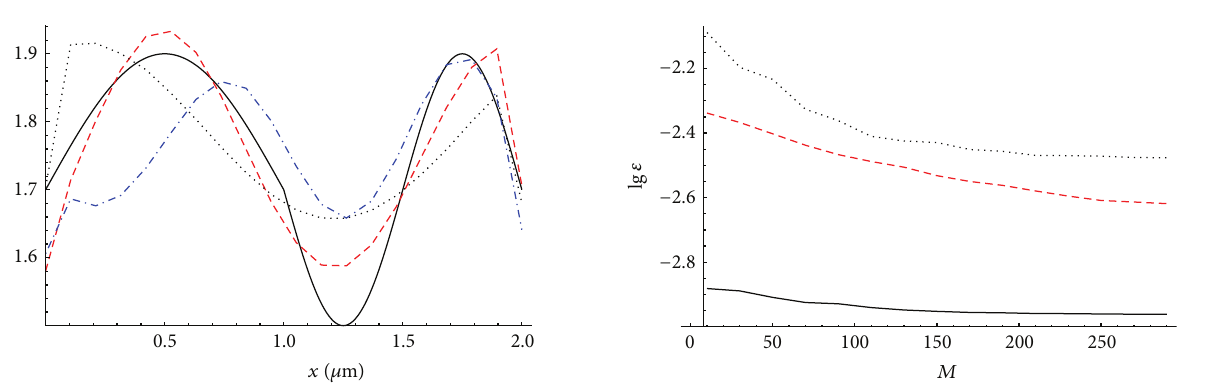
Figure 8: The relative error of reconstruction of 𝑛 2 (𝑥) for the parabolic layer versus the number of iterations 𝑀 . Refractive index is continuous in the whole domain. The solid curve corresponds to reconstructing frequencies 65–67 THz, the red dashed curve corresponds to reconstructing frequencies 36–38 THz, and the dotted curve corresponds to reconstructing frequencies 89–91 THz.